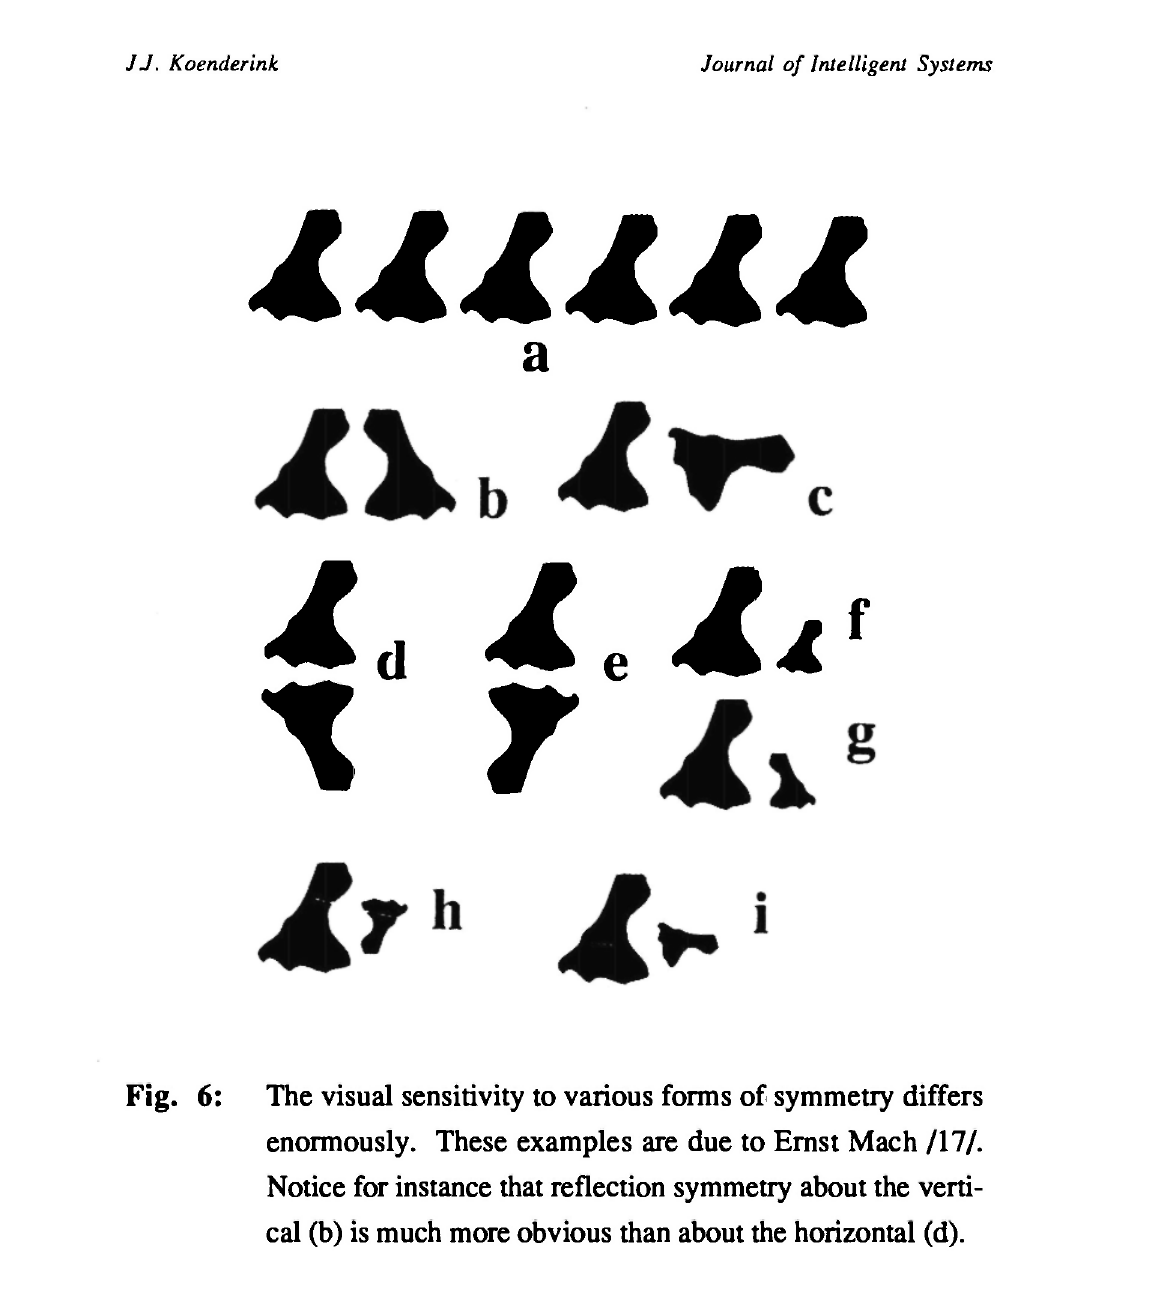
Fig. 6: The visual sensitivity to various forms of symmetry differs enormously. These examples are due to Ernst Mach